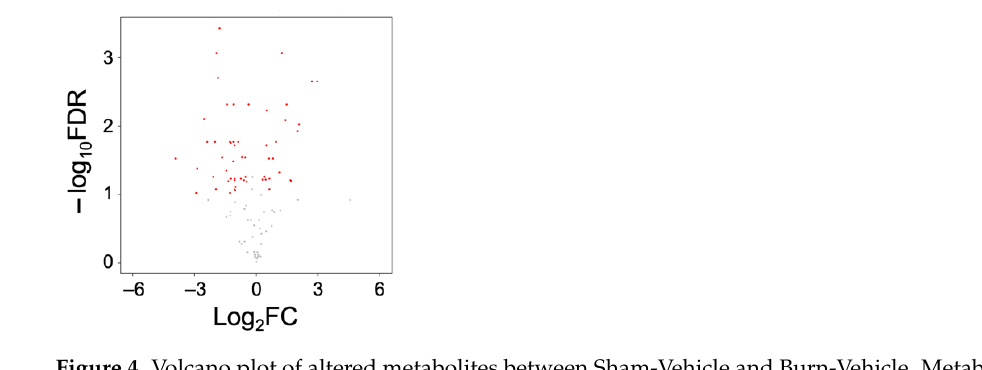
Figure 4. Volcano plot of altered metabolites between Sham-Vehicle and Burn-Vehicle. Metabolites with an absolute fold change (FC) > 1.2 and false discovery rate (FDR) < 0.10 are plotted. Red: FDR < 0.1, Grey: ≥ 0.1.